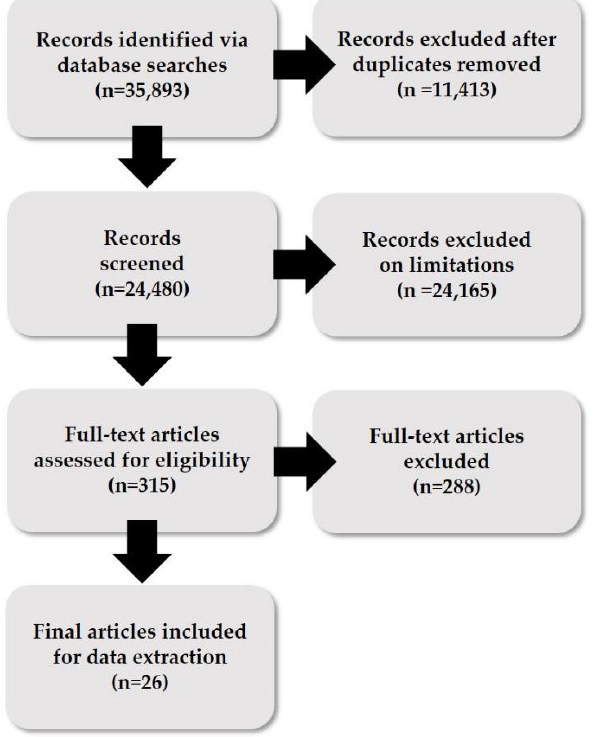
Figure 1. Flow diagram of review process.